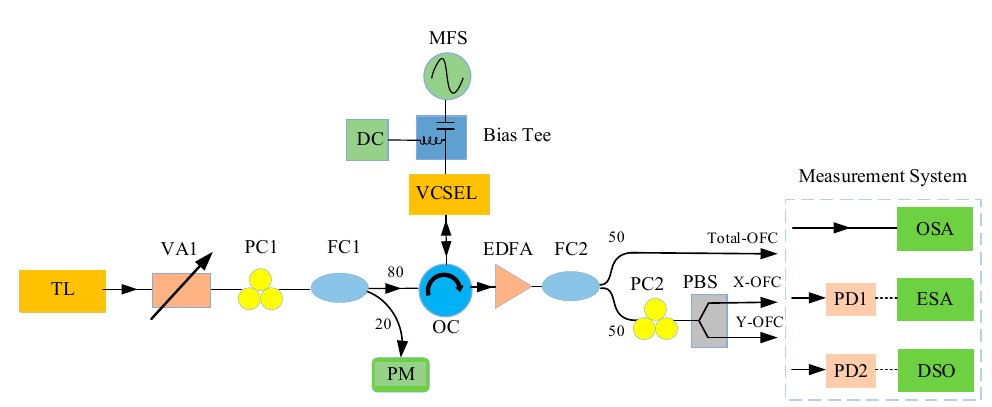
Figure 1. Schematic of the experimental setup. TL: tunable laser; VCSEL: vertical-cavity surface-emitting laser; VA: variable attenuator; PC: polarization controller; FC: fiber coupler; PM: power meter; OC: optical circulator; MFS: microwave frequency synthesizer; DC: direct current; EDFA: erbium doped fiber amplifier; PBS: polarization beam splitter; OSA: optical spectrum analyzer; PD: photodiode; ESA: electrical spectrum analyzer; DSO: digital storage oscilloscope.